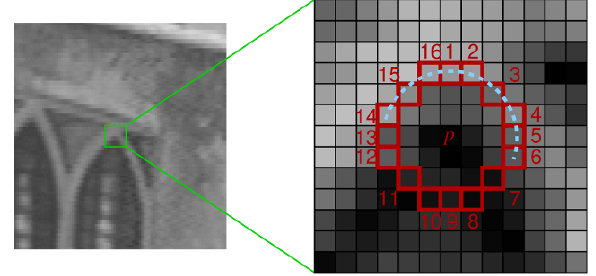
Figure 3. FAST feature detection. Courtesy of